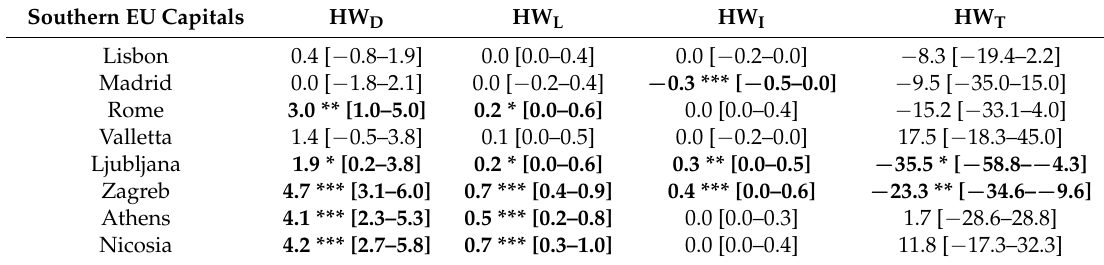
Table 4. Trend slopes (5-year change), statistically significant changes and 95% confidence interval (square brackets) of the heatwave hazard characteristics (HW D : heatwave days; HW L : long heatwaves; HW I : high-intensity heatwaves; HW T : the timing of the first simultaneously long and high-intensity heatwave) in southern EU capitals. Significant trends are shown in